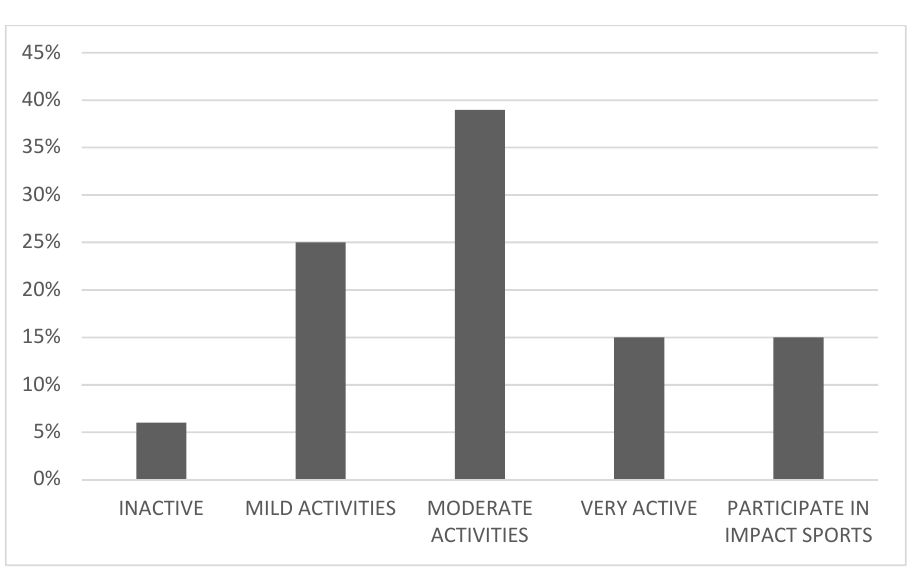
Figure 3. HOOS score. Outcomes were considered excellent for HOOS > 90 points, acceptable for 60 ≤ HOOS ≤ 90 points, and poor for HOOS < 60 points, in each domain.